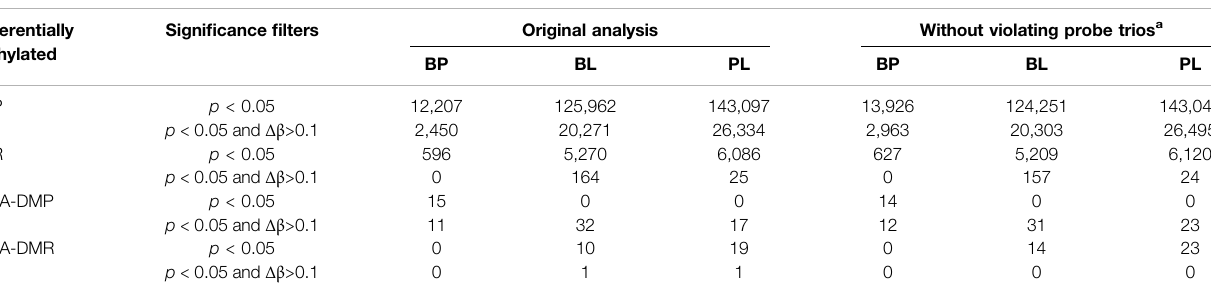
TABLE 2 | Number of differentially methylated probes and regions. Differentially Signi fi cance fi lters Original methylated